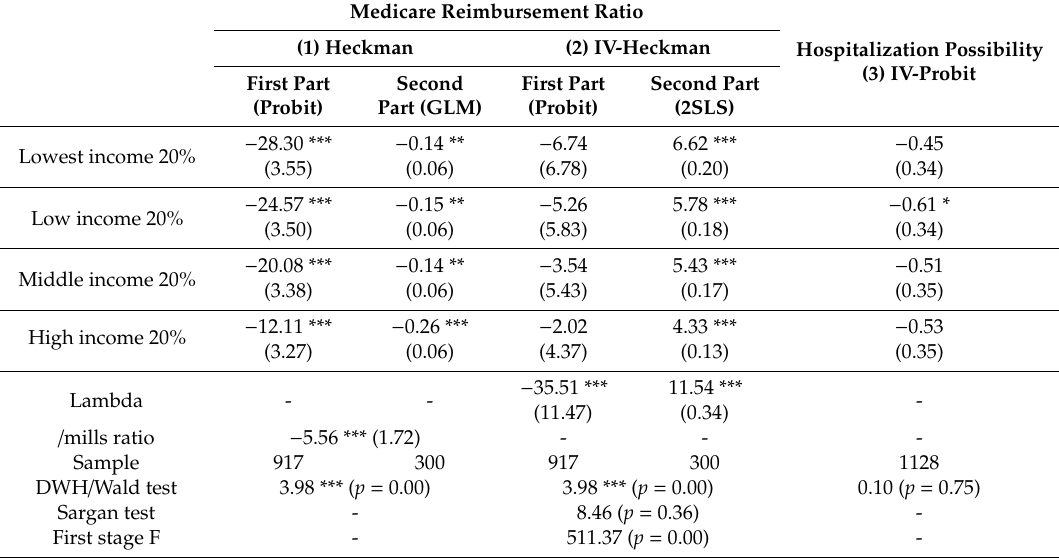
Table 2. Medical insurance compensation level and hospital